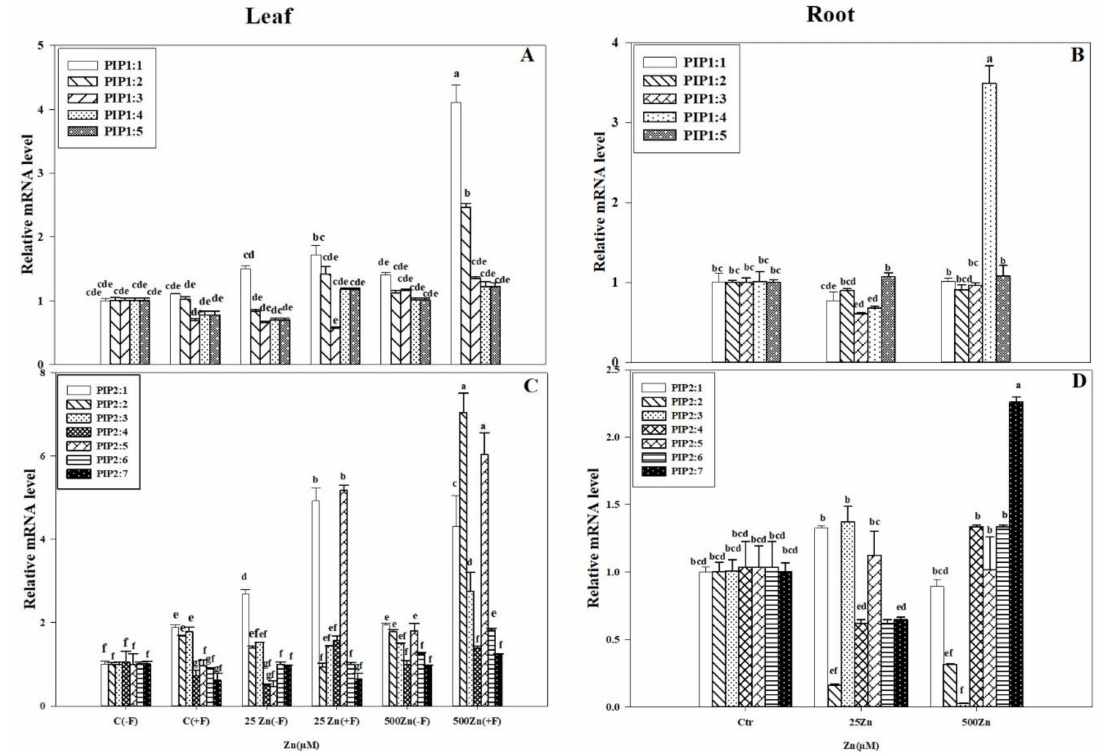
Figure 5. Relative expression level of aquaporin isoforms after short-term application of Zn: ( A ) PIP1 in root, ( B ) PIP1 in leaf, ( C ) PIP2 in root, ( D ) PIP2 in leaf, determined by Q-RT-PCR (quantitative real time-polymerase chain reaction) in control plants and plants treated with 25 or 500 µ M Zn. In leaf tissues, gene expression was determined in both non-sprayed ( − F) and sprayed ( + F) leaves. Mean values and standard errors are shown ( n = 3). Bars with di ff erent letters represent significant ( p < 0.05) di ff erences after ANOVA and an LSD